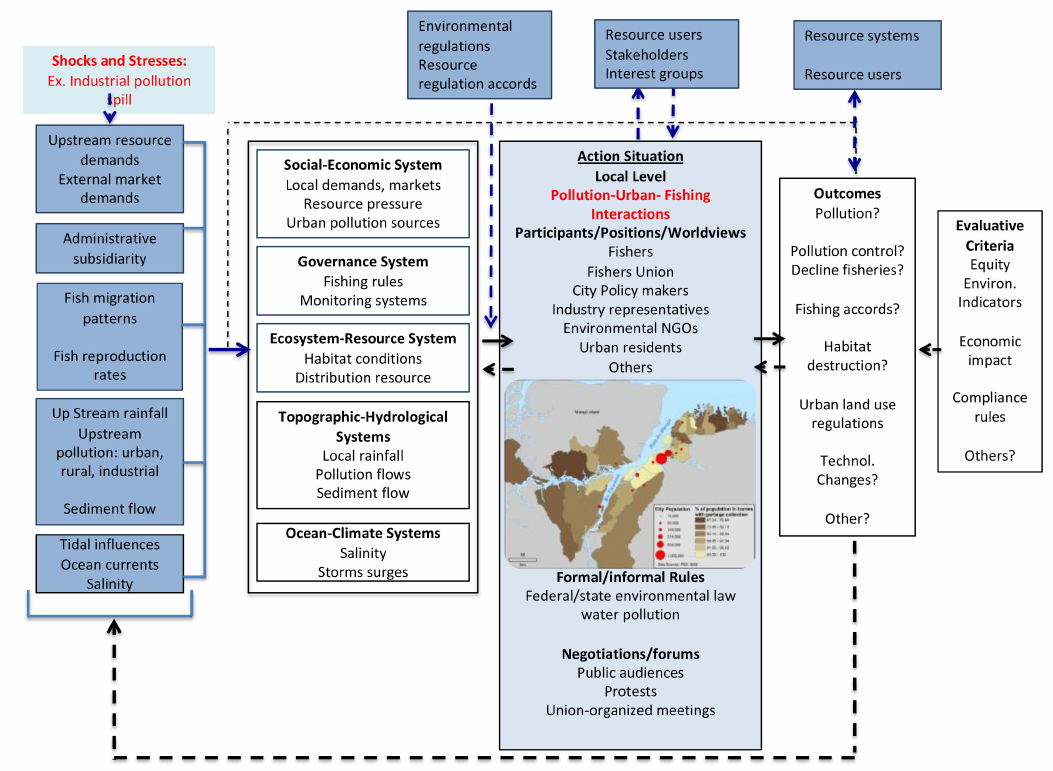
Figure 6. Illustrative application of the framework to map out the impact of urban growth and pollution on small-scale fisheries in riparian areas and mangroves of the Amazon delta. From [2] with permission from